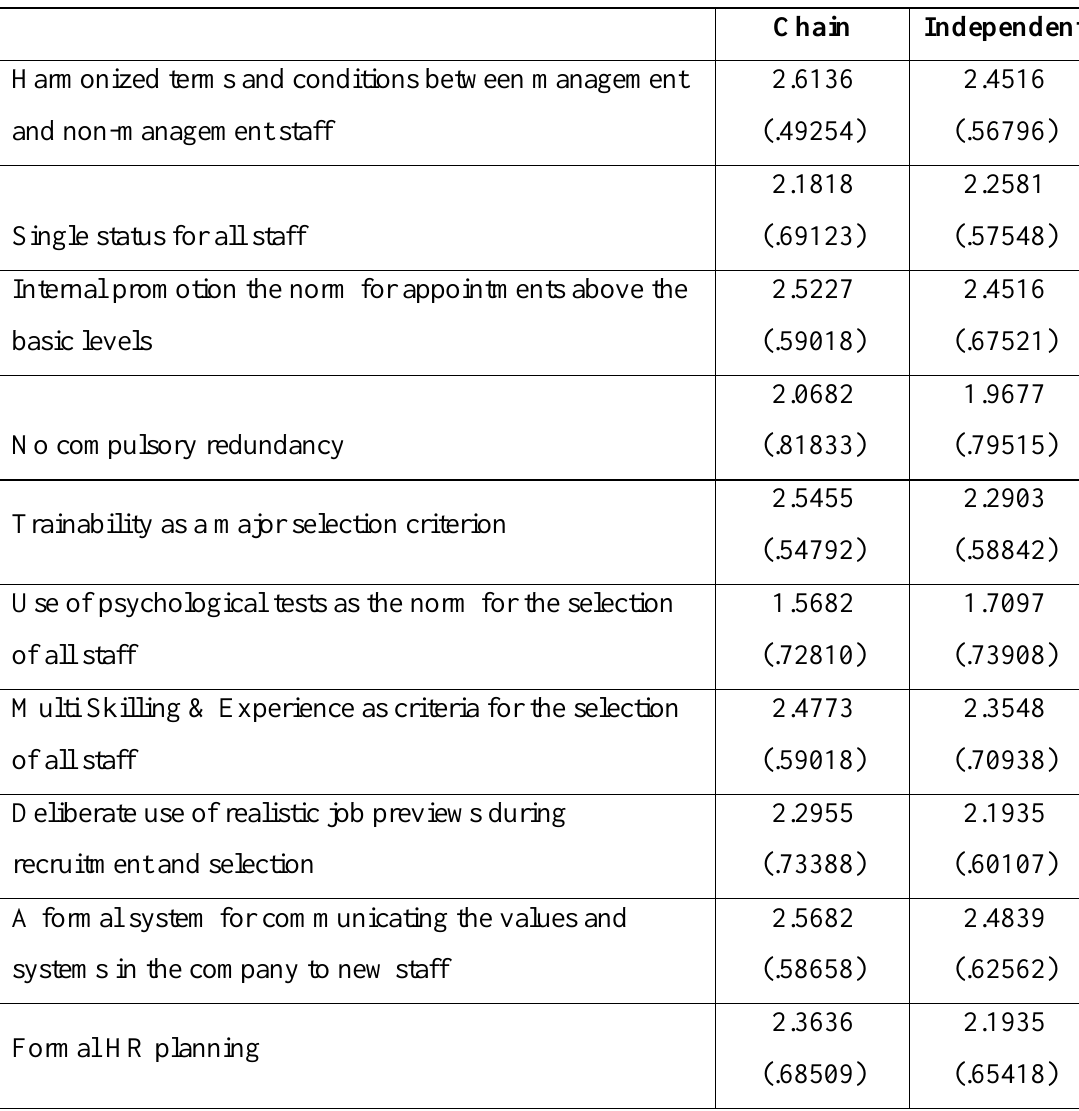
Table 6: HRM Practices